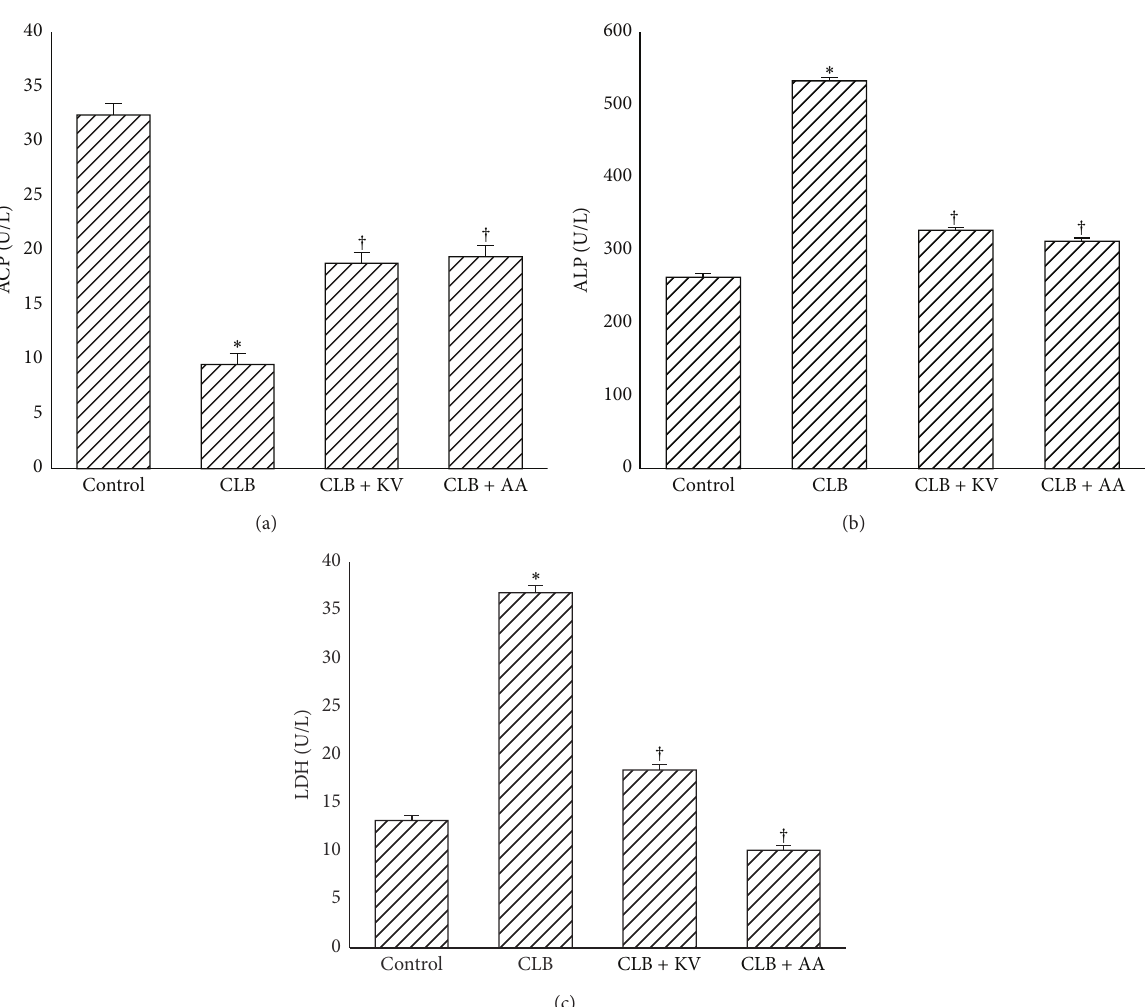
Figure 3: Protective effect of kolaviron and L-ascorbic acid on chlorambucil-induced changes in testicular ACP, ALP, and LDH in rats. Results are expressed as mean ± S.D (𝑛 = 5) ; ACP: acid phosphatase, ALP: alkaline phosphatase, LDH: lactate dehydrogenase, CLB: chlorambucil (0.2 mg/Kg b.w.), KV: kolaviron (100mg/Kg b.w.), and AA: ascorbic acid (100mg/Kg b.w.). ∗ Significantly different from CTRL; † Significantly different from